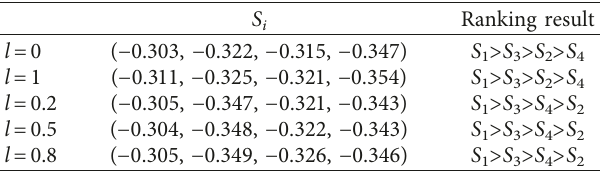
Table 8: The value of each potential low-carbon suppliers and the rank results comparison for the construction